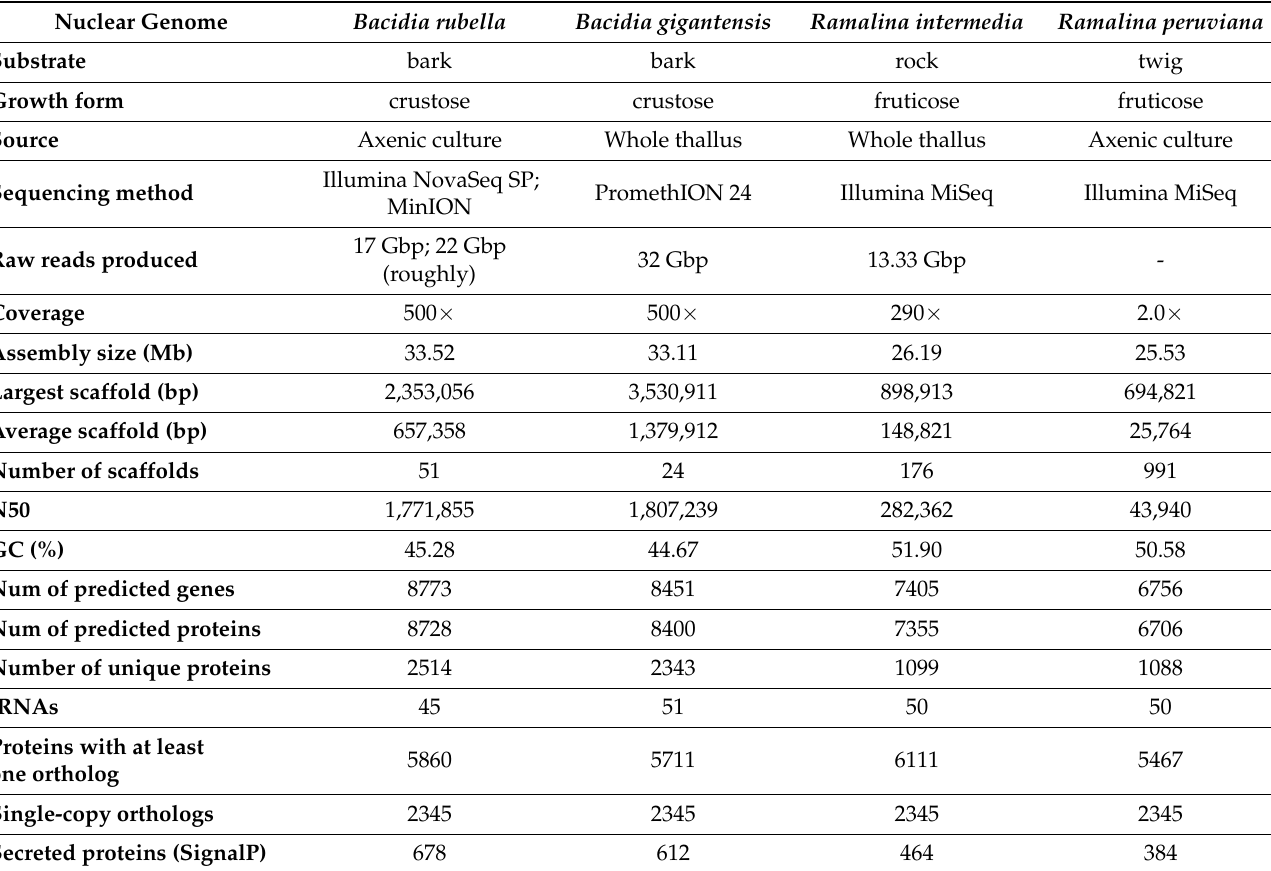
Table 1. Starting material, sequencing strategy and genome quality statistics of Ramalinaceae genomes analyzed in this